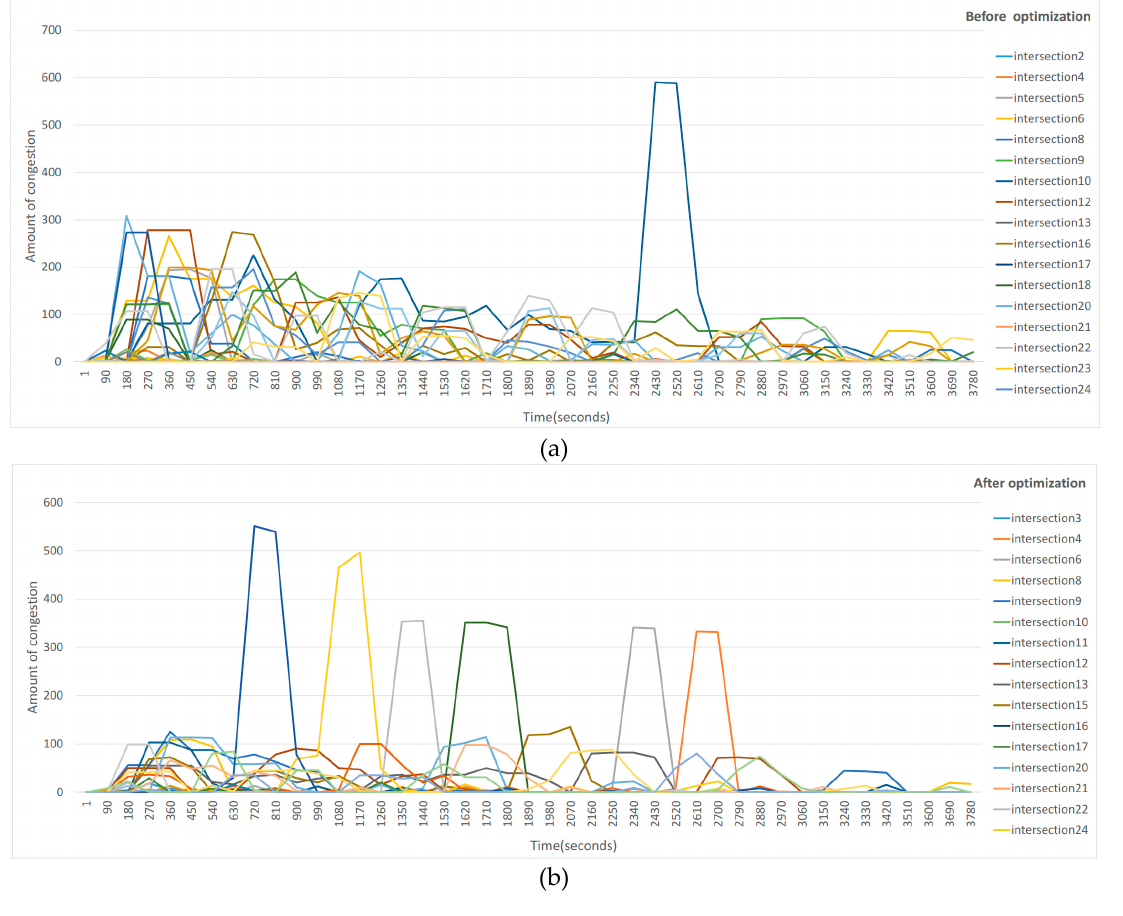
Figure 9. Comparison of traffic conditions before and after the optimization of the road network. ( a ) The traffic conditions of road intersections before optimization; ( b ) The traffic conditions of road intersections after optimization.